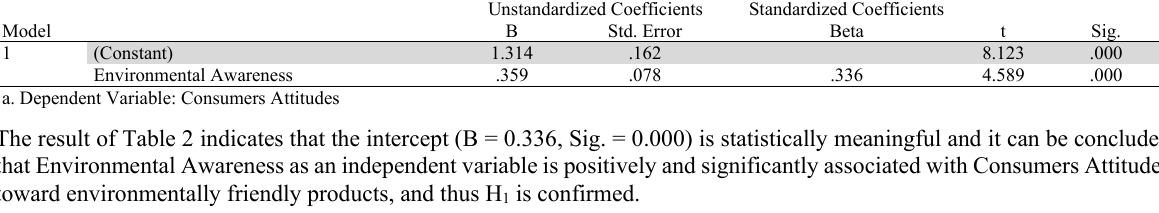
Simple Regression Analysis Between Awareness and Attitudes